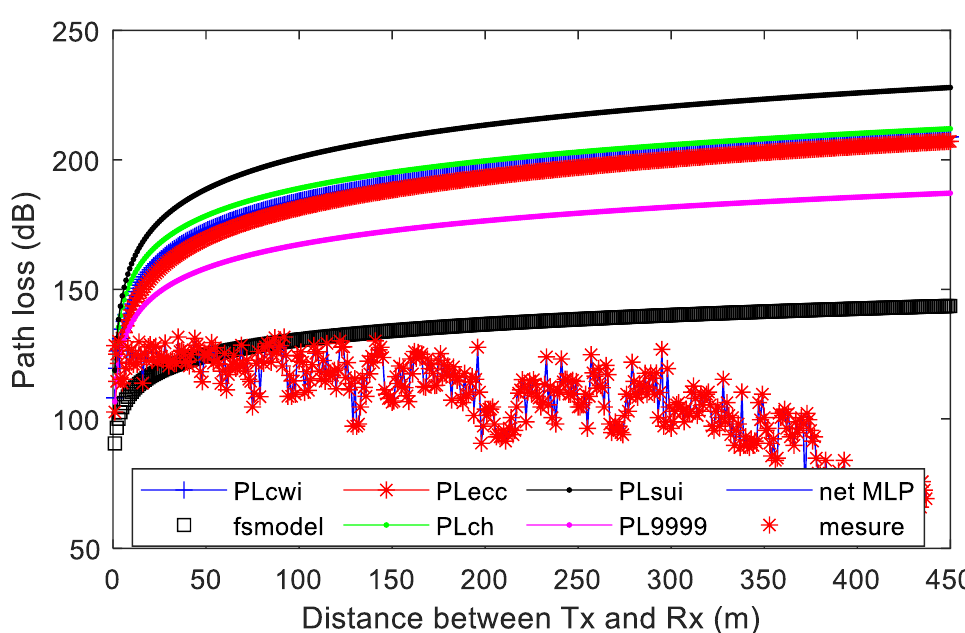
Figure 12. Comparison between empirical models and MLP (with one hidden layer) for Dataset 6.